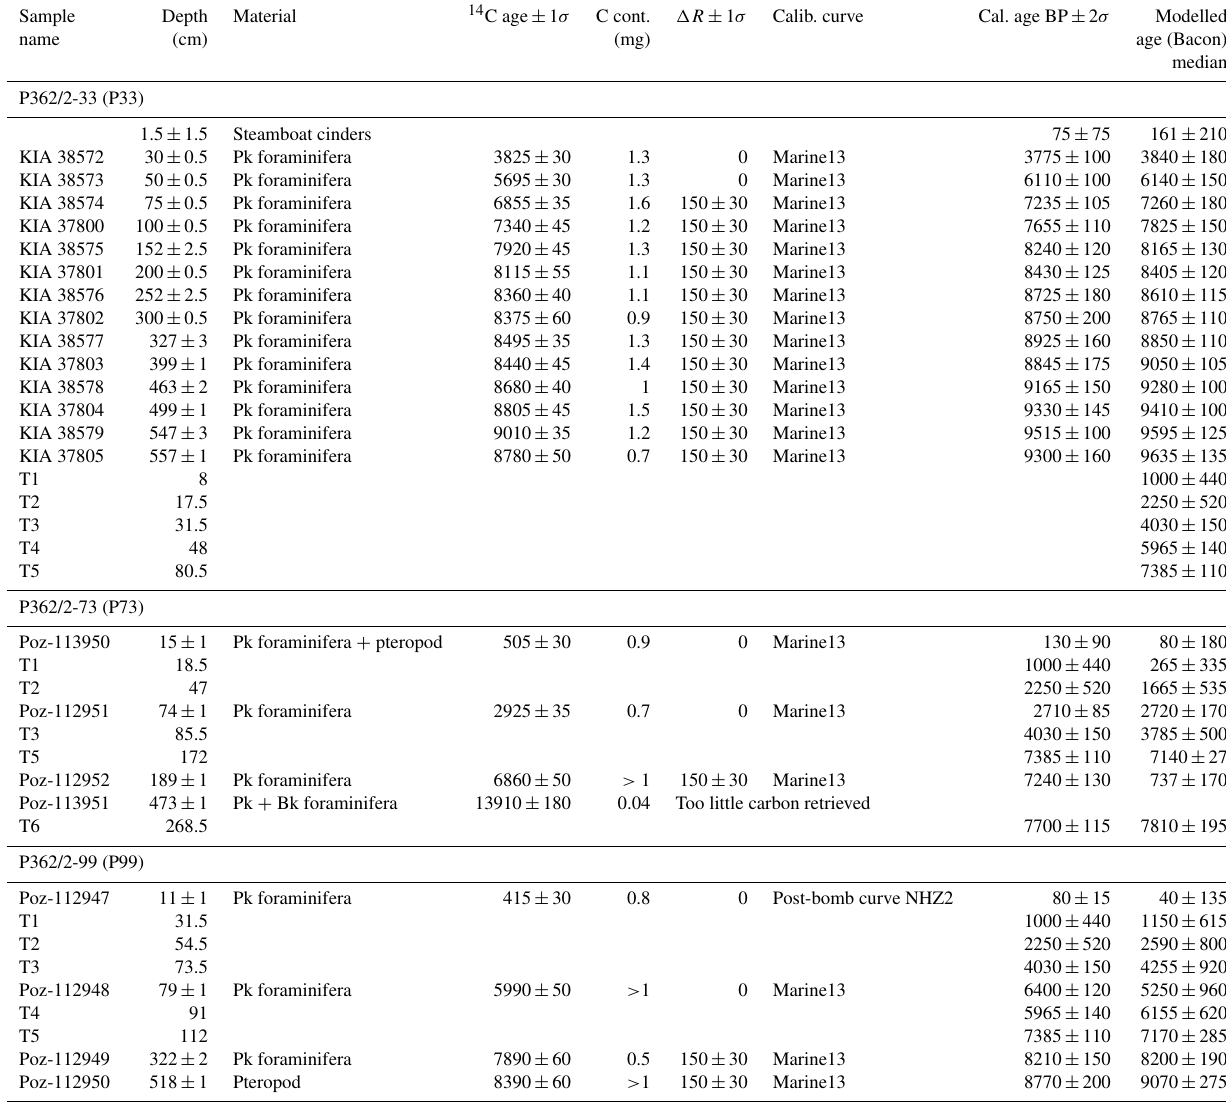
Table 2. Radiocarbon ages, tie points and modelled ages for cores P33, P73 and P99. Radiocarbon ages for core P33 from Blanchet et al. (2013), with new modelled ages with uncertainties for the entire core (using Bacon V2.3, Blaauw and Christen, 2011). Six tie points were defined on the Ti / Ca record of P33 (T1 to T6; see Sect. 3.2 and Fig. 2). New radiocarbon measurements, tie points and modelled ages with uncertainties for cores P73 and P99. In the column “Material”, “Pk foraminifera” and “Bk foraminifera” refer to planktonic and benthic foraminifera,